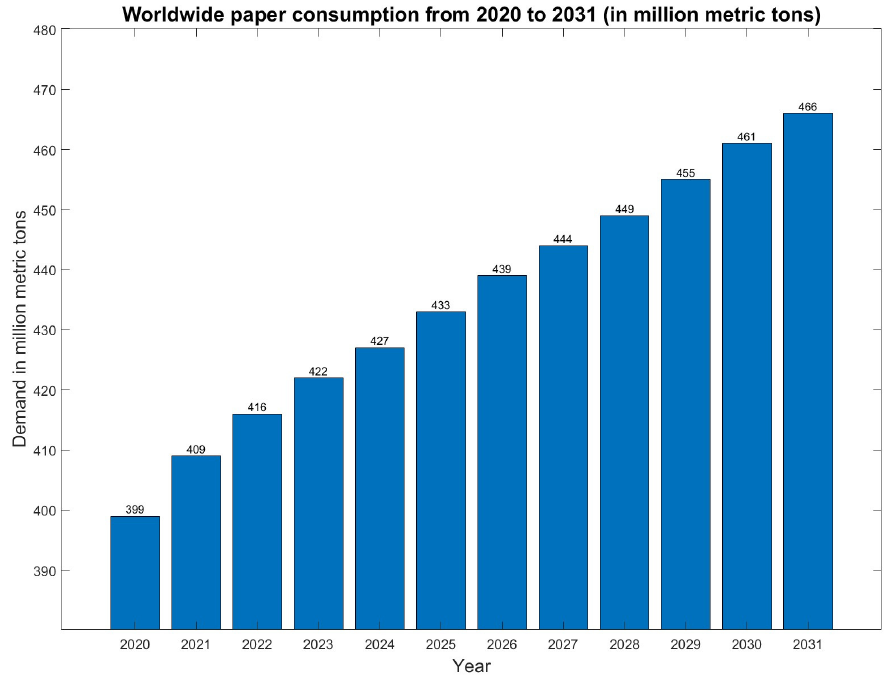
Figure 1. Worldwide paper consumption prediction